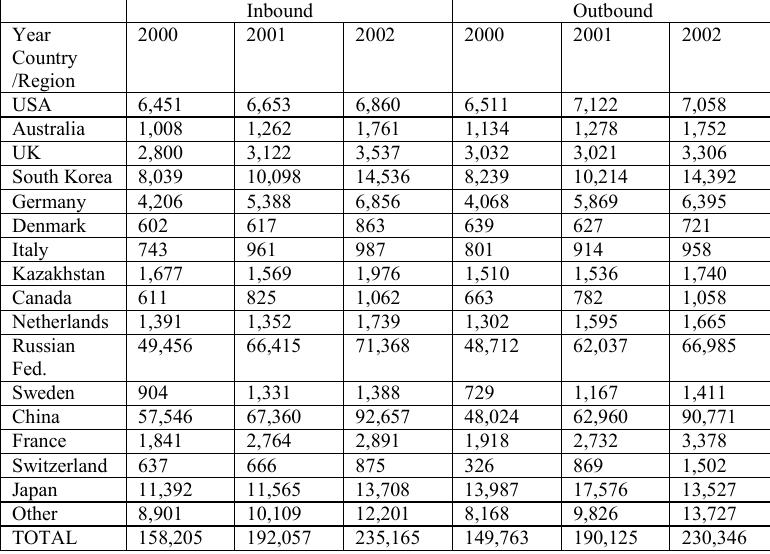
Source: Mongolian Statistical Yearbook 2002 , Ulaanbaatar: National Statistical Office of Mongolia, 2003, pp.